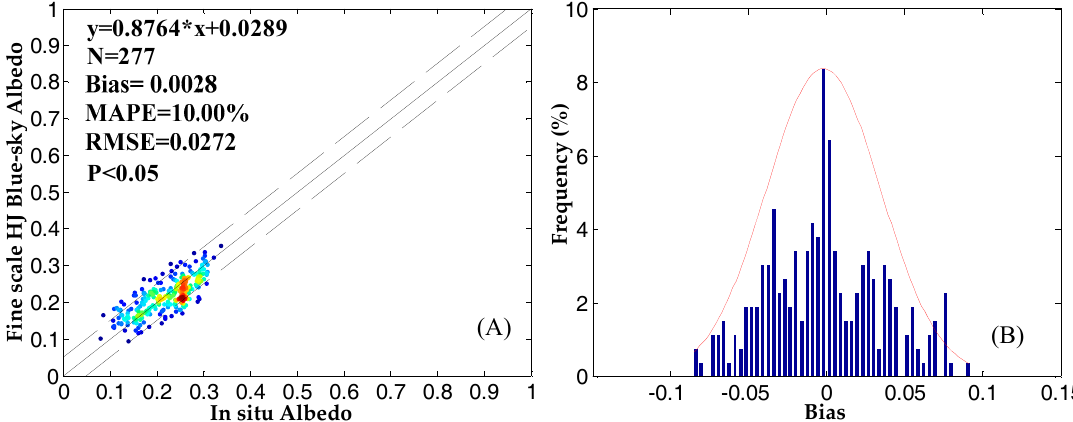
Figure 9. Scatter plots and bias histogram between fine scale albedos and the in situ albedos: ( A ) in situ albedo vs. the fine scale albedo; ( B ) Bias histogram of fine scale blue-sky albedo minus the in situ albedo The colors refer to the density of points (from highest (red) to lowest (blue).